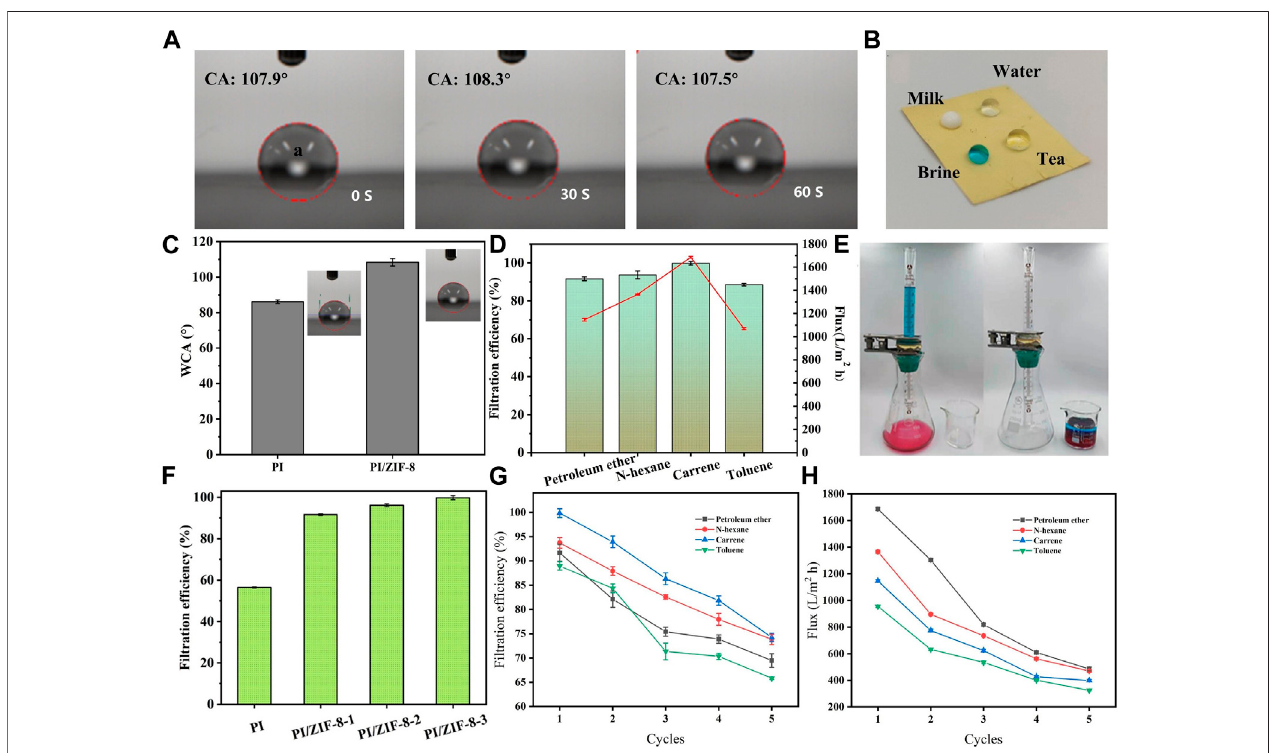
FIGURE6|(A) ContactanglesofhydrophobicZIF-8/PInano fi bermembranes. (B) Dropletsofdifferentpollutionlevelscanbekeptspherical. (C) Thewater-contact angles of both the PI nano fi ber membranes and the PI/ZIF-8 nano fi ber membranes were measured. (D) Water – oil separation ef fi ciency. (E) Filter unit diagram. (F) The fi ltration ef fi ciency of dichloromethane by PI membrane with different doping amount of ZIF-8. (G) Circulating fi ltration ef fi ciency. (H) Circulating fi ltered oil fl ux.